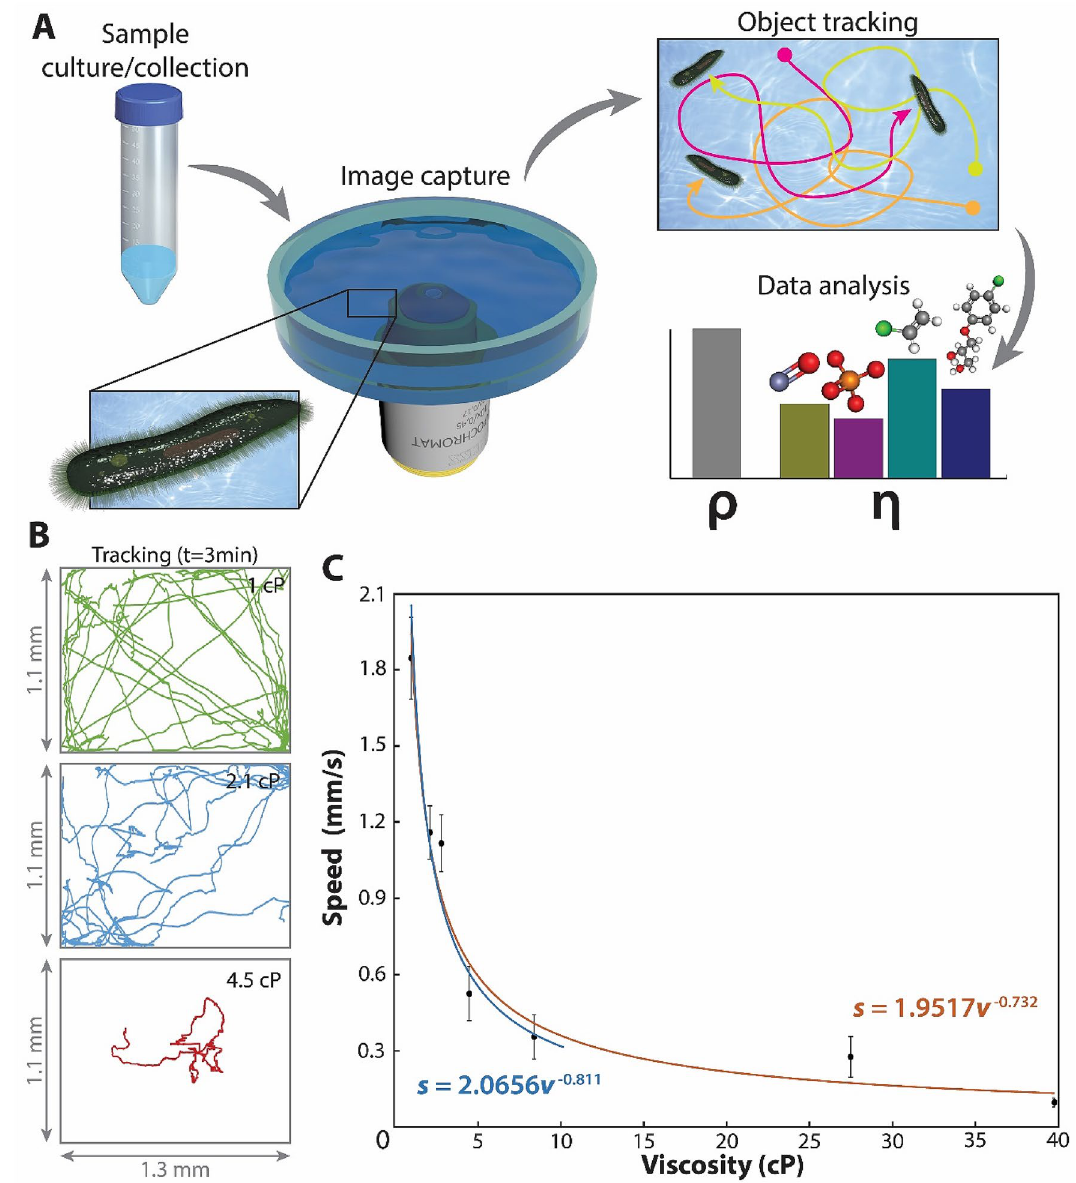
Figure 1. Automated tracking of Paramecium and measurement of viscosity. ( A ) The movement of Paramecia Aurelia cells in water samples is recorded for three minutes. Each cell is identified and followed through the video frames by an object tracking system. Their path is converted to cartesian coordinates, their speed calculated and correlated with changes in viscosity or presence of pollutants. Examples of path tracking are included in the Supplementary Fig. 1 and video 1. ( B ) Characteristics examples of the path followed by Paramecia for 3 min showing the whole field of view of the experiment conducted in water (top, green), 0.01% Methylcellulose (middle, blue), and 0.5% Methylcellulose (bottom, red). ( C ) Speed vs. viscosity for Paramecia . The red line is the fitting of the data to a power-law function for the whole range of viscosities tested (1–40 cP, R 2 = 0.93). The blue line is the same fitting for the range of moderate viscosities (1–10 cP; R 2 = 0.95). Error bars represent the standard deviation for the paths collected at each set of conditions (i.e., 30 Paramecia and paths per represented datapoint). Cumulative paths are presented in Supplementary Fig.